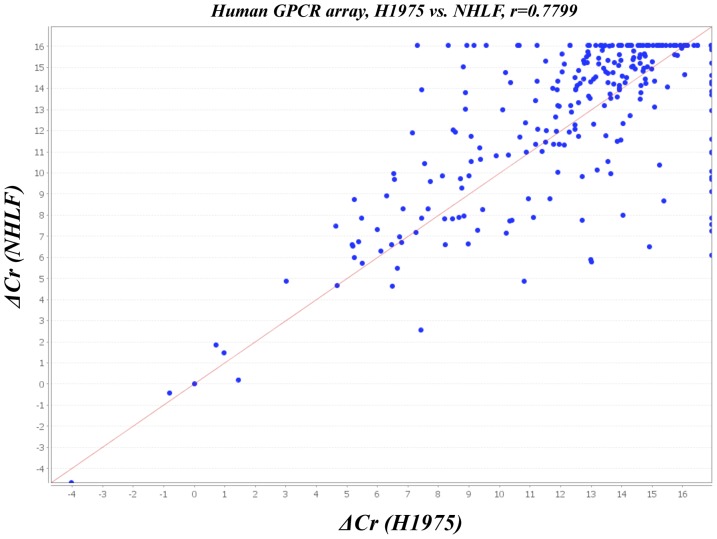
Pearson's correlation scatter plot of GPCR levels in NHLF and H1975 cells (R = 0.7799).Human GPCR expression was analyzed by microarrays.